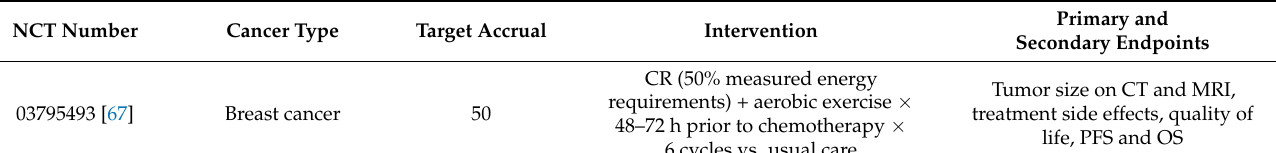
Table 3. Summary of ongoing studies testing insulin-lowering dietary strategies in patients with metastatic